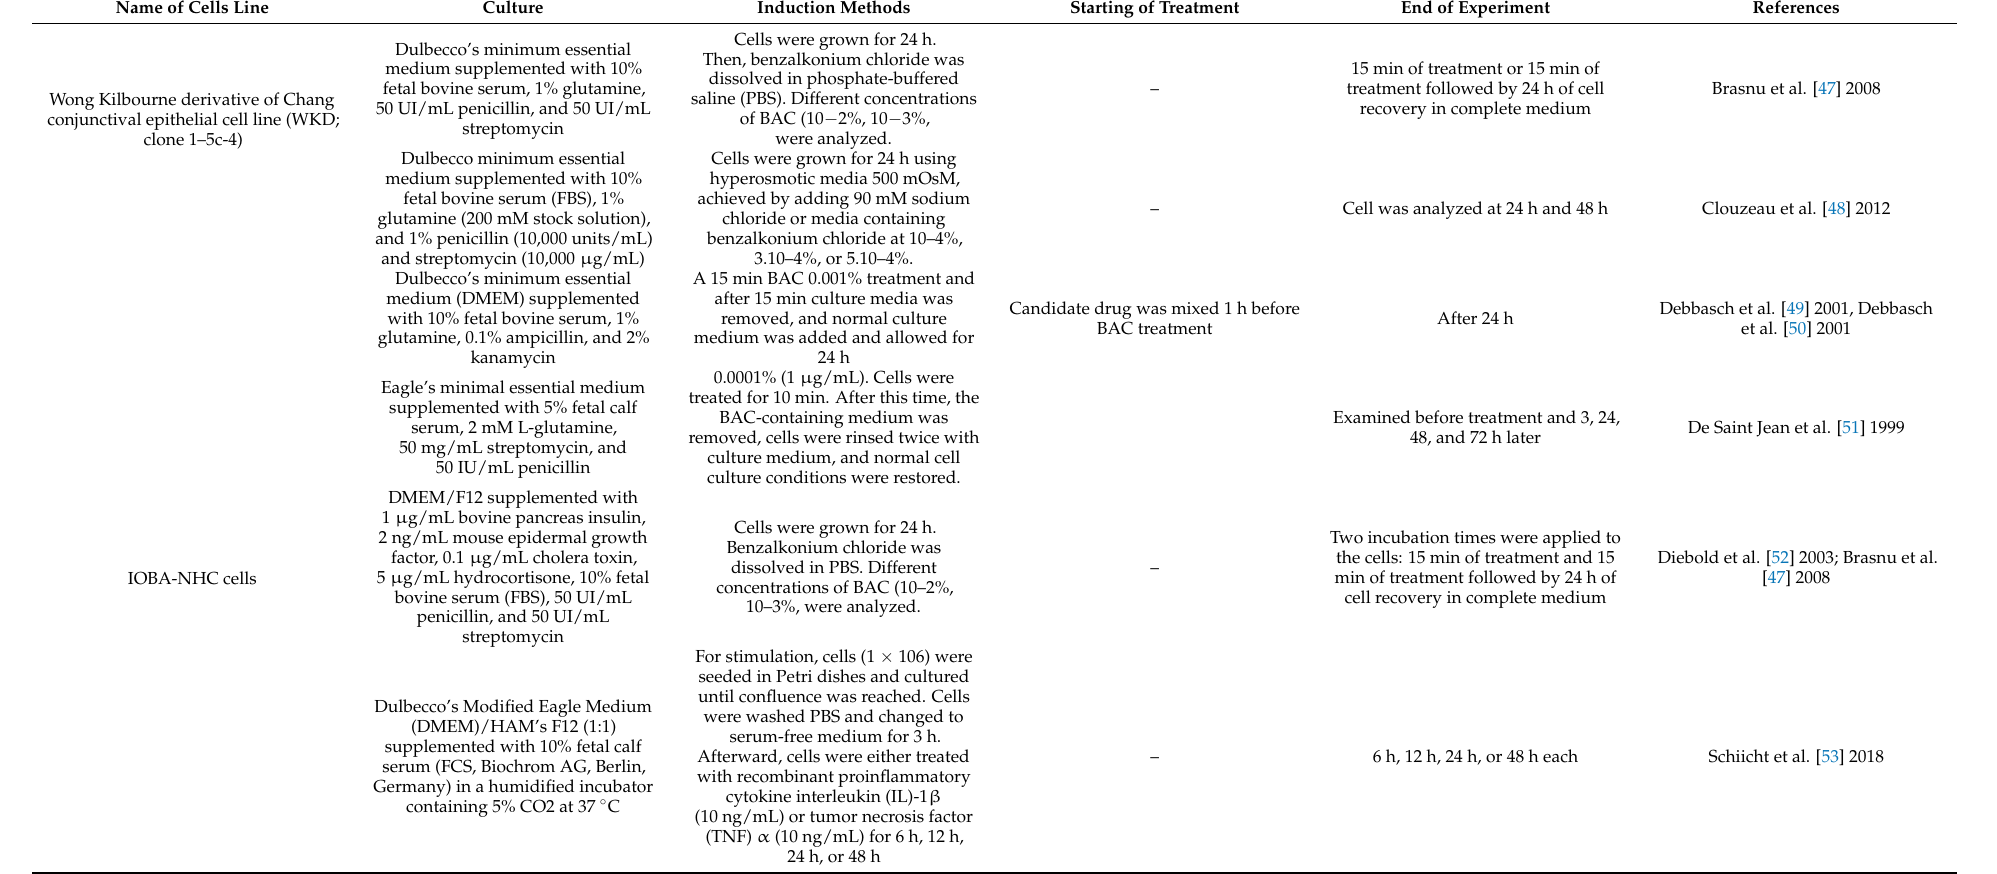
Table 2. The available cell lines and primary cells, culturing methods, induction, and end point of in vitro DED experiment. Name of Cells